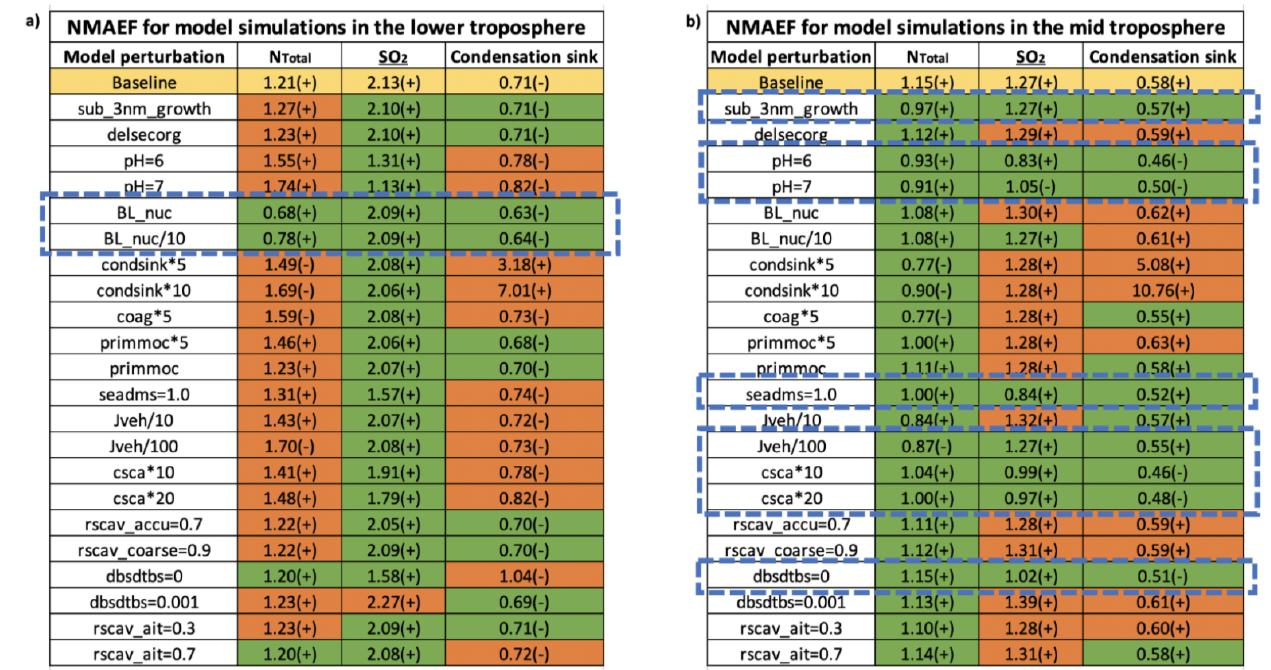
Table A2. Normalised mean absolute error factor (NMAEF) with respect to N Total , SO 2 and condensation sink for different model simu- lations. NMAEF values for the baseline simulation are highlighted in yellow. NMAEF values that are less than (or equal to) the baseline simulation are highlighted in green. NMAEF values that are greater than the baseline simulation are highlighted in orange. The plus ( + ) and minus ( − ) signs next to each NMAEF value indicate whether the bias is positive or negative. The dotted blue box indicates the model sim- ulation for which NMAEF values for N Total , SO 2 and condensation sink are less than (or equal to) the baseline simulation